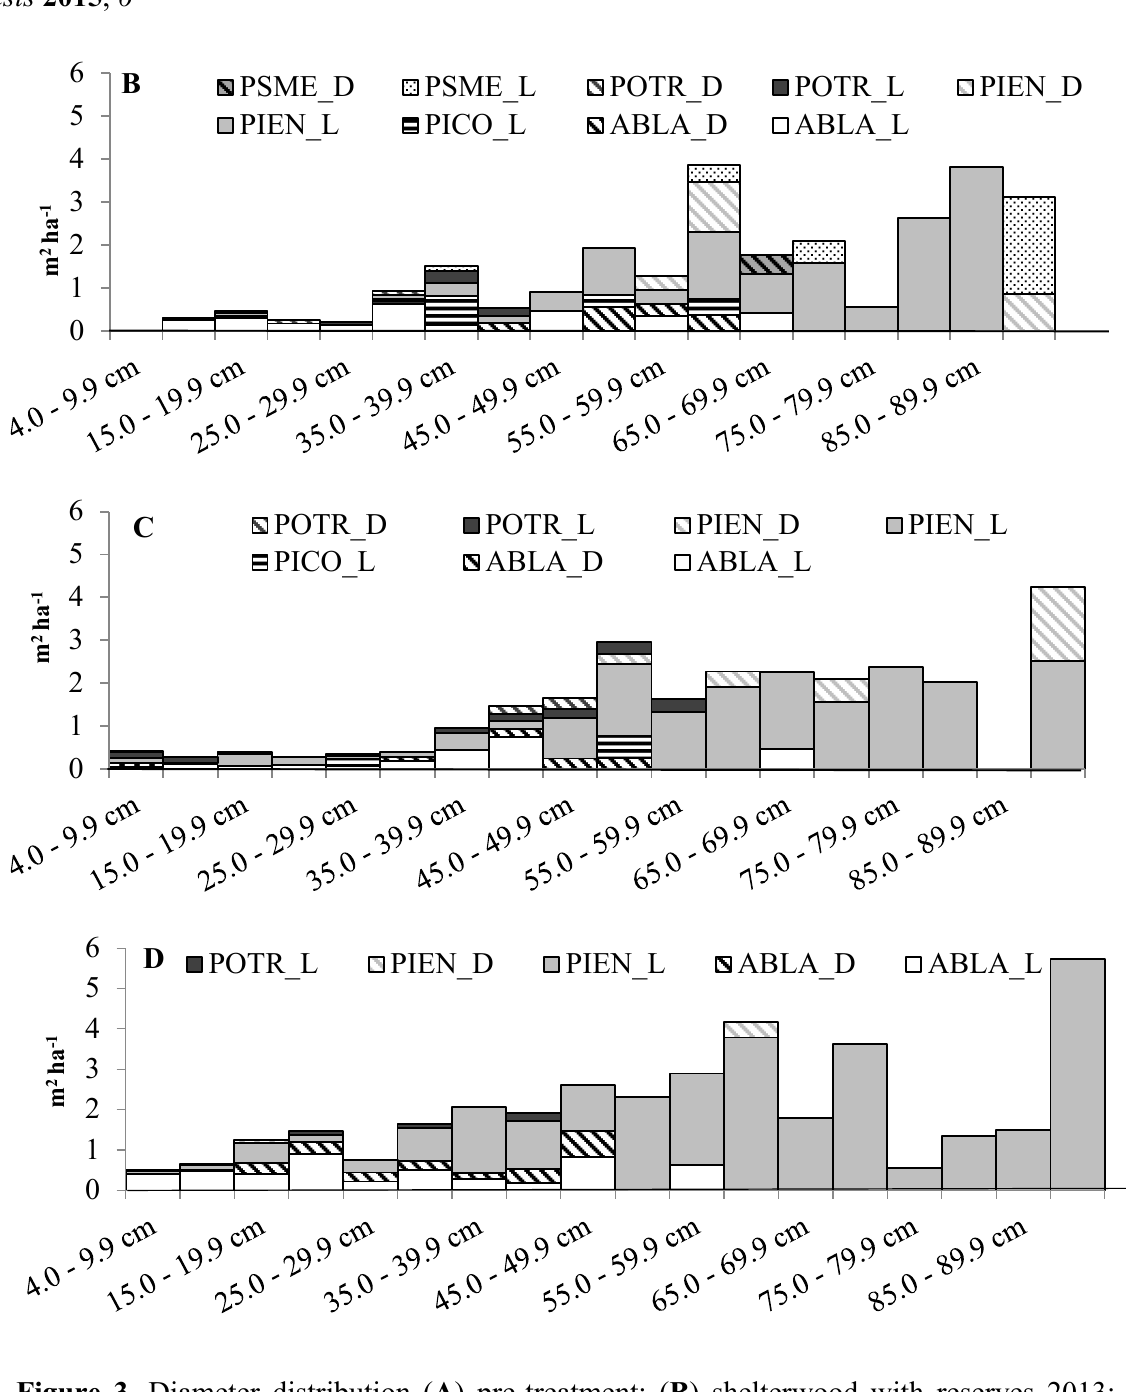
Figure 3. Diameter distribution ( A ) pre-treatment; ( B ) shelterwood with reserves 2013; ( C ) group selection 2013; ( D ) single tree selection 2013. Species codes